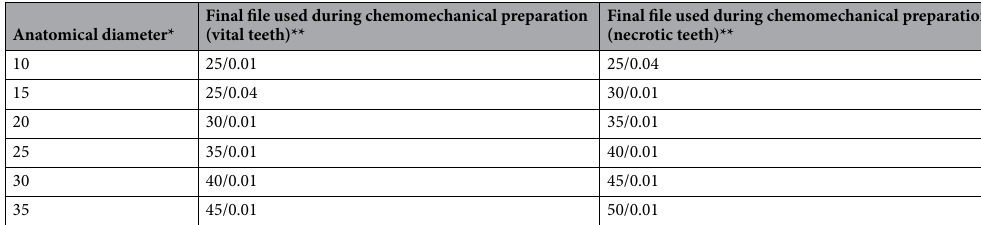
Table 1. Planning the amplitude of the chemomechanical preparation based on the anatomical diameter in vital and necrotic teeth. *K-Flexofiles. **NiTi file of the ProDesign Logic system (Easy Equipamentos